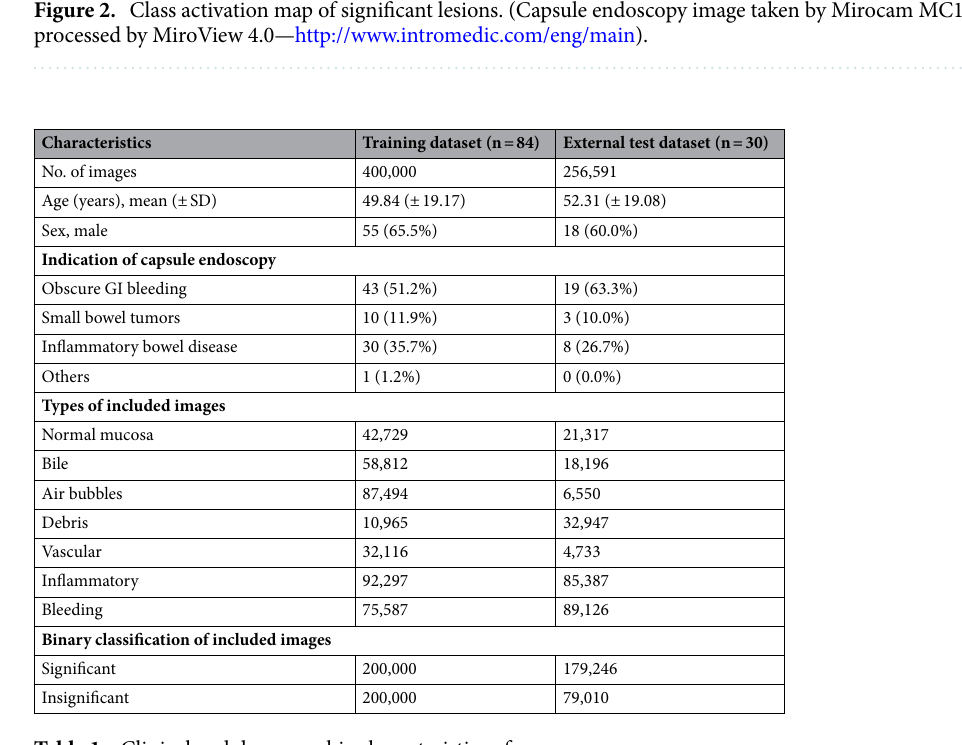
Table 1. Clinical and demographic characteristics of